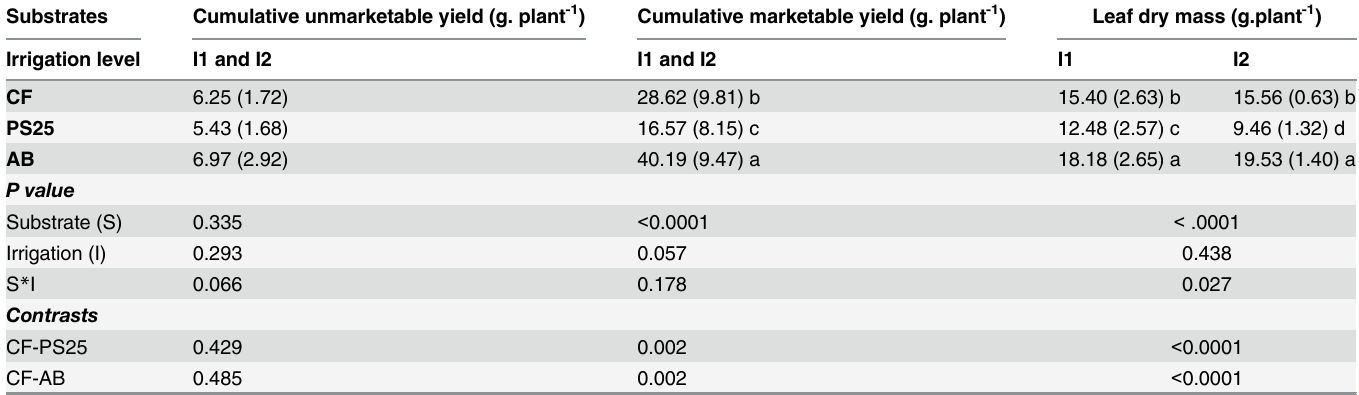
Table 3. Cumulative unmarketable and marketable yields and leaf dry mass at the end of the experiment for strawberry plants grown in CF, AB and PS25 substrates. Significant differences between group means were determined by ANOVA at P = 0.05. Cumulative unmarketable yield (g. plant -1